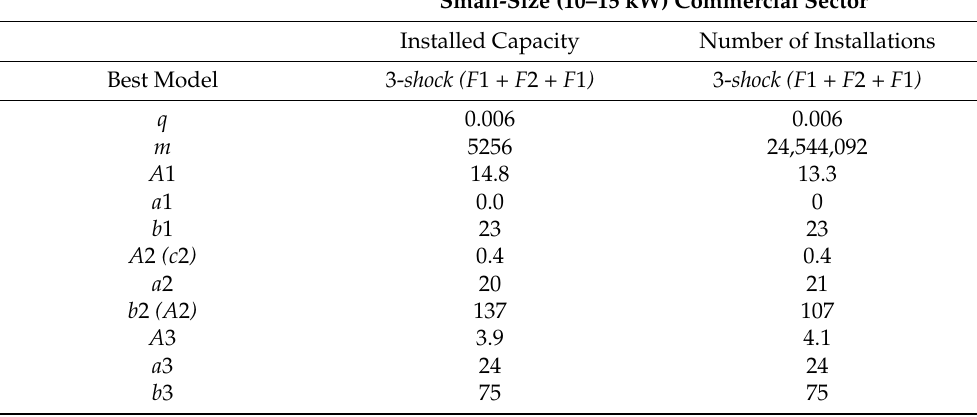
Figure A4. Observed vs. fitted (by the best GIM model) PV monthly adoptions in the UK 2010–2021, for the small-size (10–50 kW) systems of the commercial sector: ( left ) installed capacity ( F 1 + F 2 + F 1); ( right ) number of installations ( F 1 + F 2 + F 1). Table A4. Estimates of GIM parameters for the time series of PV adoptions in the UK 2010–2021 for the small-size (10–50 kW) commercial sector for the two types of data series considered (by installed capacity and by numbers of installations). The best-fit model is reported including the estimates of the basic Bass parameters ( 𝑞,𝑚 ) as well as the type and number of shocks.